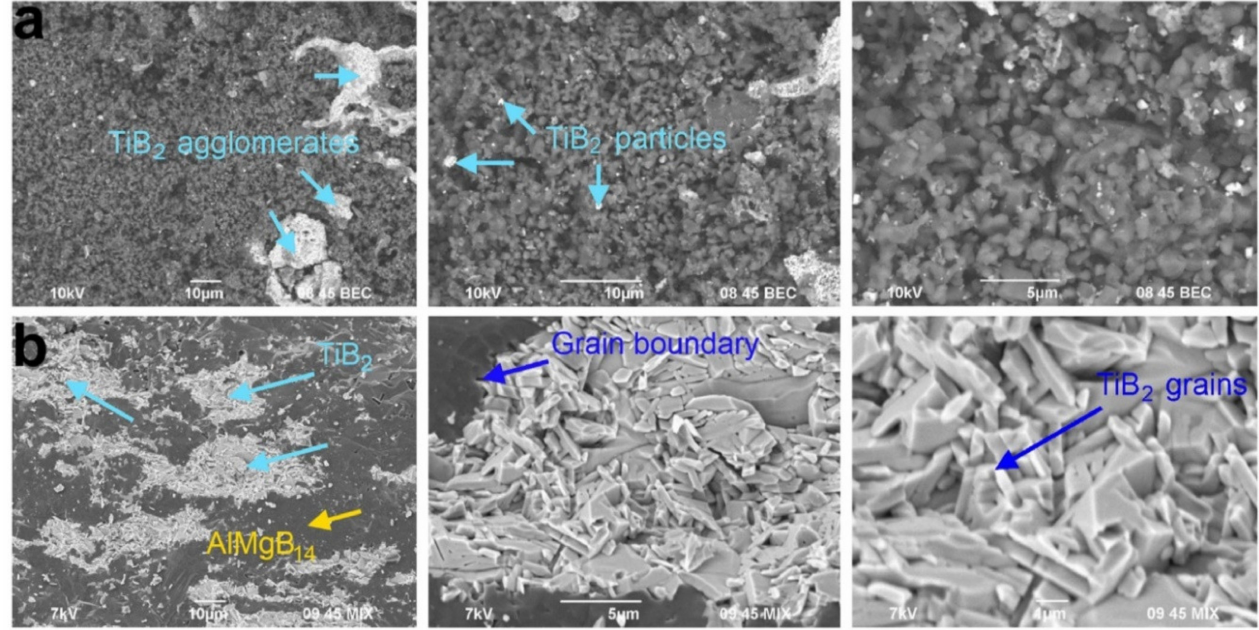
Figure 9. SEM images of SHS powder ( a ) and dense samples sintered by SPS at 1450 ◦ C ( b ). Reprinted from Nikitin et al., 2020 with copyright permission, Ceramics International